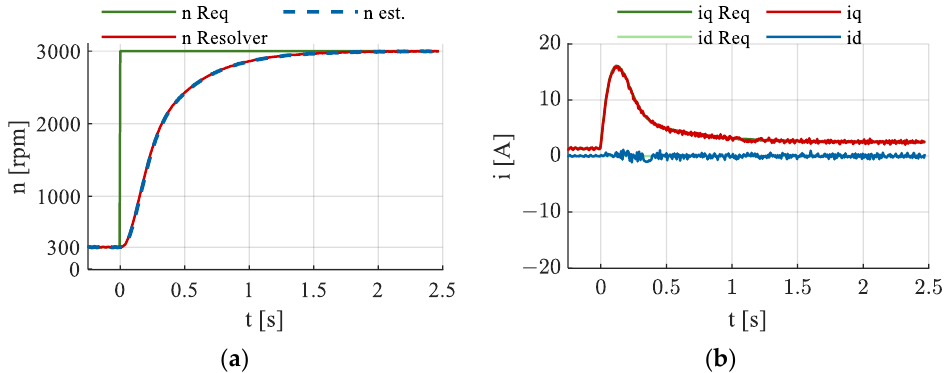
Figure 17. Startup transient of the emergency three-phase operation: ( a ) rotor speed; ( b ) current in d – q subsystem.